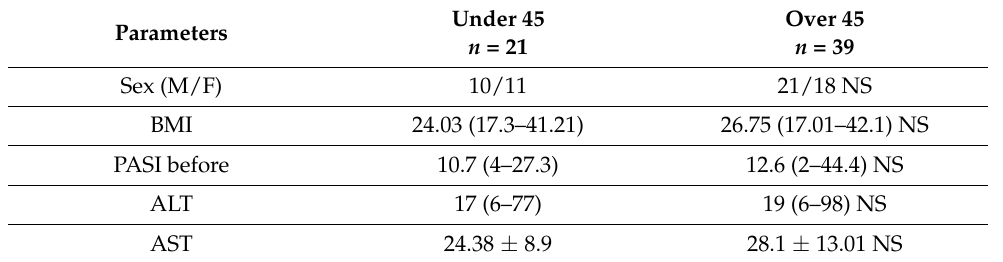
Table 2. Division and comparison between two age groups of